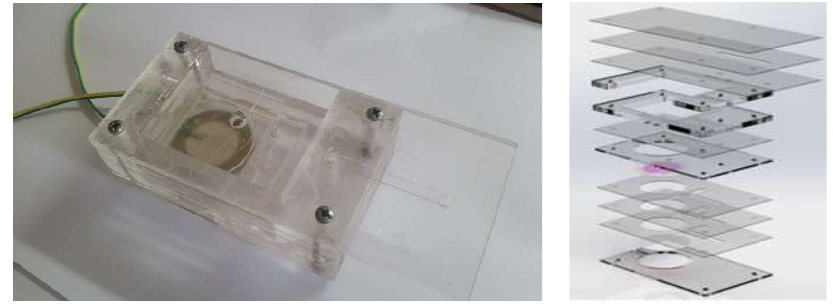
Figure 7. Top and exploded views fabricated micropump.